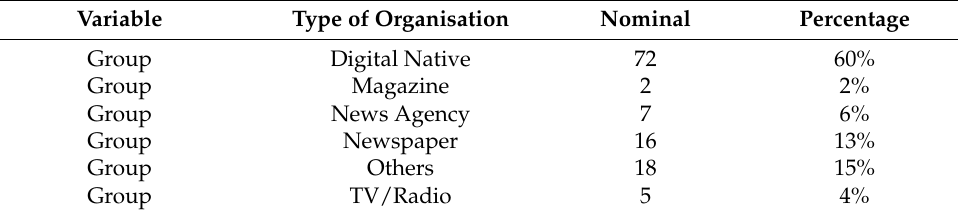
Table 9. Type of